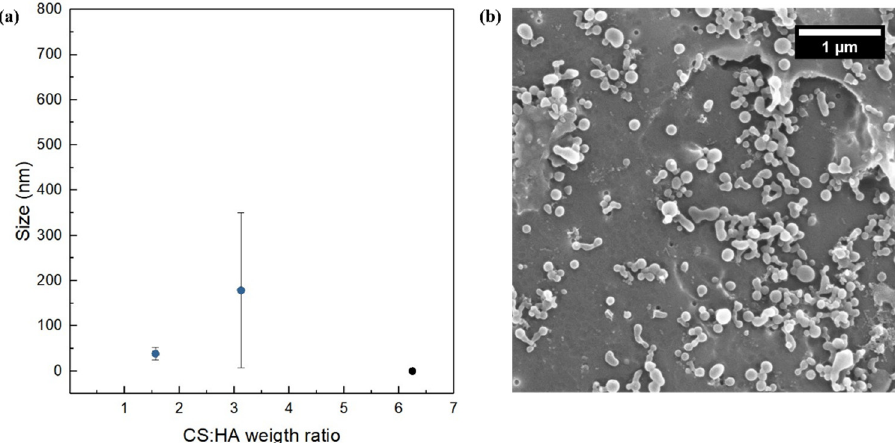
Figure 4. NPs’ size and morphology at different polymer ratios at high flow rate regime and FR 2 = 0.5: ( a ) Plot of NP size vs. CS:HA weight ratio; ( b ) representative SEM image at CS: HA weight ratio equal to 1.56. The black point indicates that, at high flow rate regime and CS:HA = 6.25, macroaggregates and unreacted materials are obtained; therefore, the size was not measurable (see Figure S4 of the Supplementary